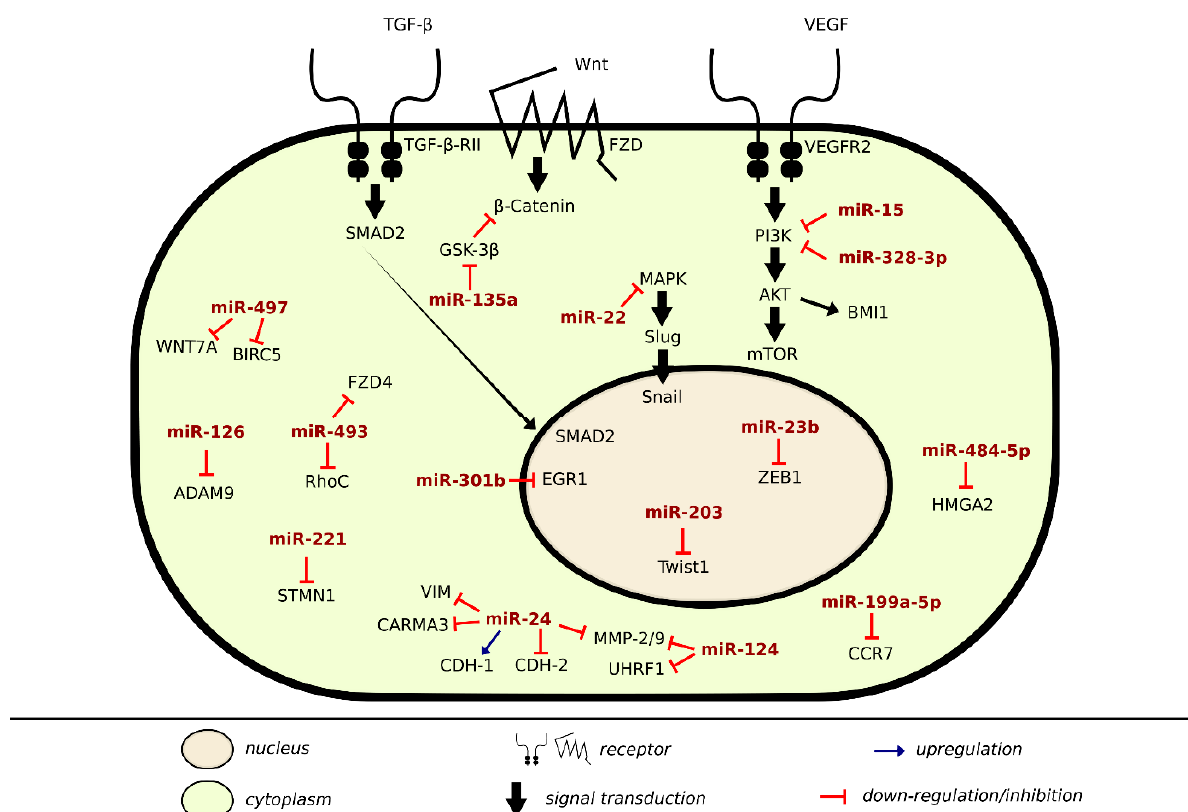
Figure 2. Metastatic inhibition and induction by miRNA in BLCA.